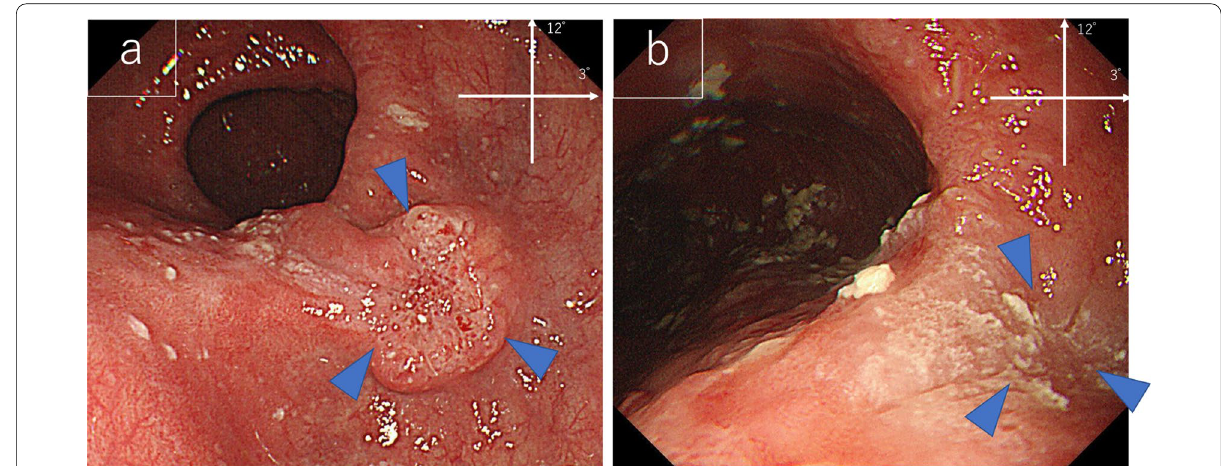
Fig. 1 Esophagogastroduodenoscopy of the middle thoracic esophageal lesion (arrow head), a before neoadjuvant chemotherapy and b immediately before surgery